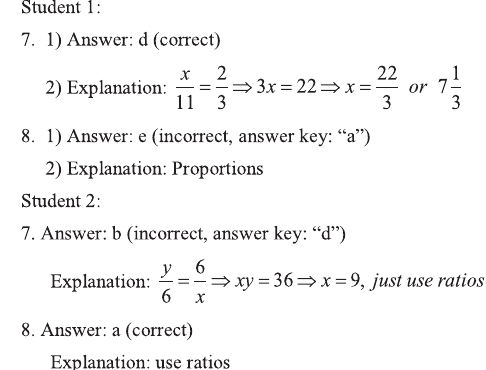
FIG. 6. Examples of two students ’ written explanations to Q7-8. Student 1 had the correct ratio of 2 ∶ 3 from the previous question pair Q5-6 and applied the proportional reasoning correctly in Q7. However, the student selected “ e ” in Q8 as the reasoning, which is incorrect. Student 2 knew to use the ratio, but failed to apply it to obtain the correct